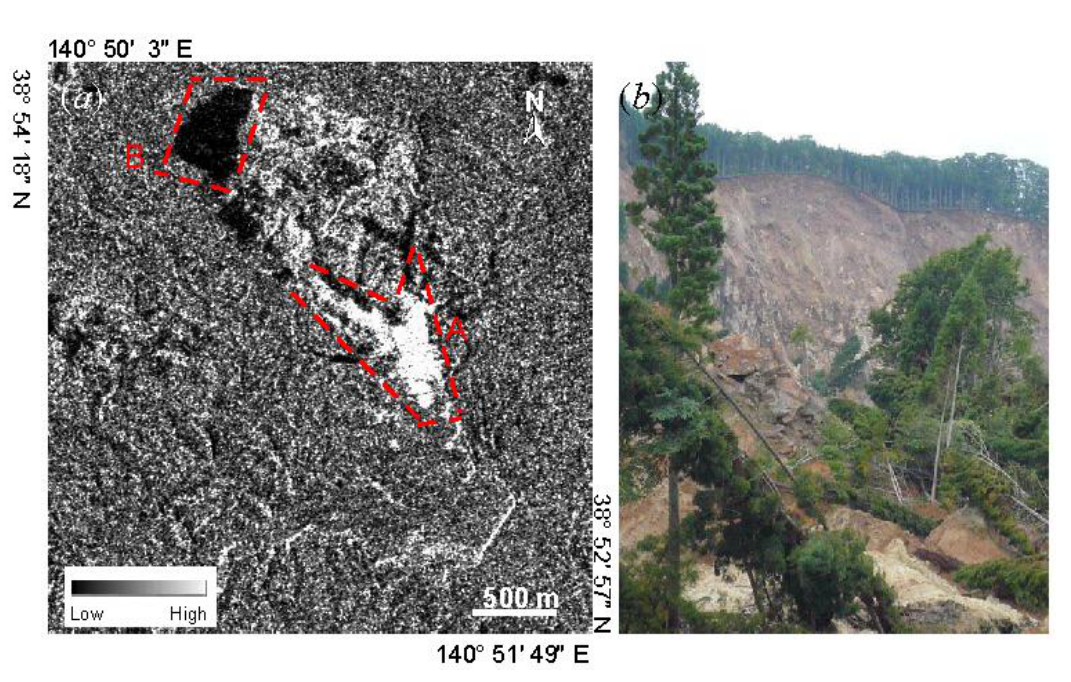
Figure 5. ( a ) Single-polarization intensity image for Aratozawa Dam reservoir area observed on 23 March 2008, divided by the image from 23 June 2008; ( b ) On-site photograph taken around Area